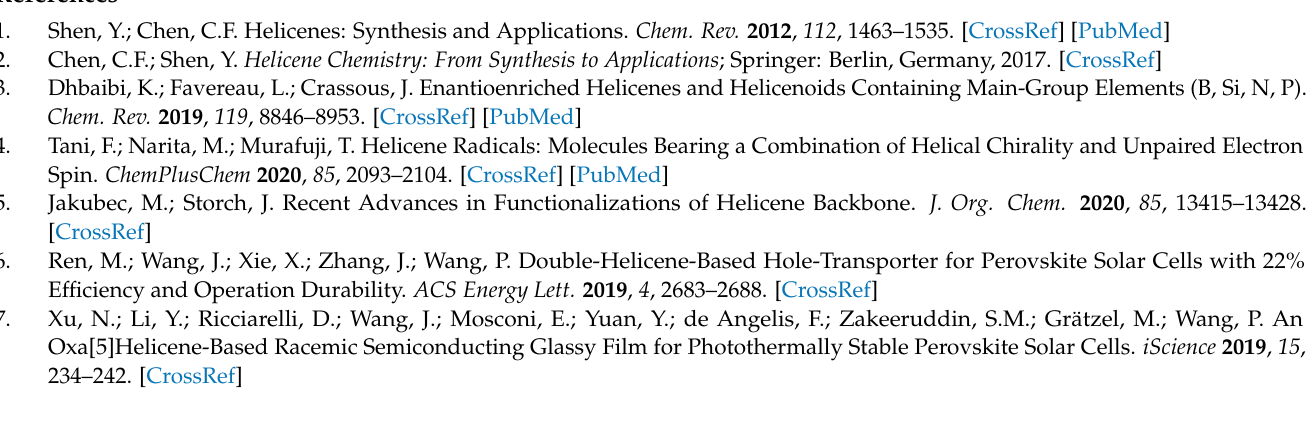
and 11 . Figure S6: Molecular graphs for 8 : 8 ( C i ) and 10 : 10 ( C i ) calculated with M06-2X/6-311+G(2d,p). Figure S7: Plots of H b ( r c ) versus H b ( r c ) − V b ( r c )/2 for H- ∗ -H, C- ∗ -H, and C- ∗ -C for 8 : 8 and 10 : 10 . Figure S8: The internal vibration motions of ν n for 7 : 7 ( C i ) from the top view. Figure S9: The internal vibration motions of ν n for 7 : 7 ( C i